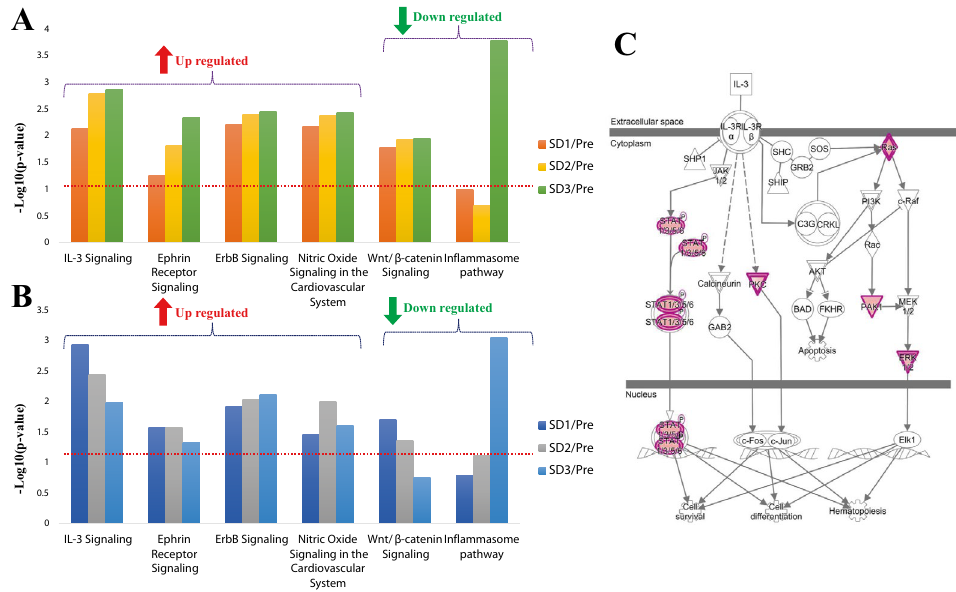
Figure 4. Ingenuity pathway analysis (IPA) showing trend of radiation related significantly dysregulated pathways in survivors ( A ) and non-survivors ( B ). The red line denotes the threshold of significance (p < 0.05). ( C ) IL-3 Signaling pathway was upregulated in the survivors at day 1. The regulatory gene nodes (in purple) were found to be upregulated in our dataset. The pathway figure is generated by Ingenuity Pathway Analysis (IPA, QIAGEN Inc. https:// www. qiagen. com/).